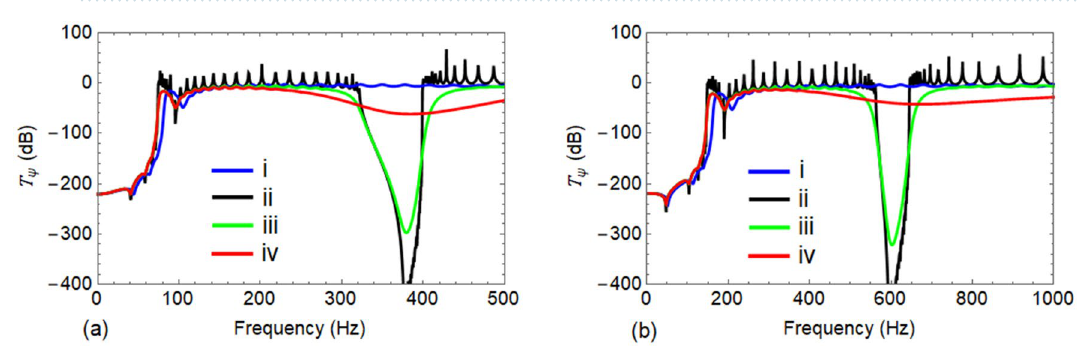
Figure 7. Transmittance T ψ ( dB ) of the undamped R 1 when attached with undamped resonators: ( a ) use of lateral localized resonators (LLRs) for Wave #A; and ( b ) use of vertical localized resonators (VLRs) for Wave #B.